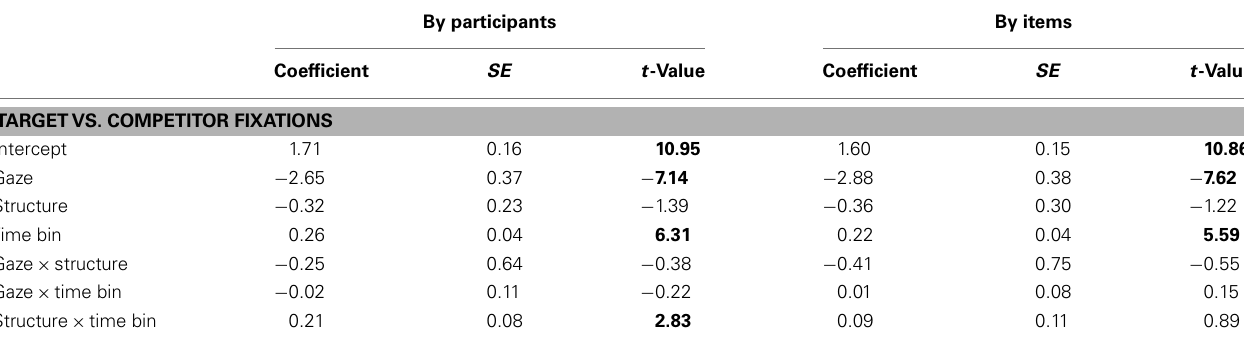
Table 4 | Experiment 1, NP2 time window: Coefficients, SE and t -values for the final models of log-ratios of target fixations.The corresponding means and SD are included in the main text where necessary for interpretation. By participants By